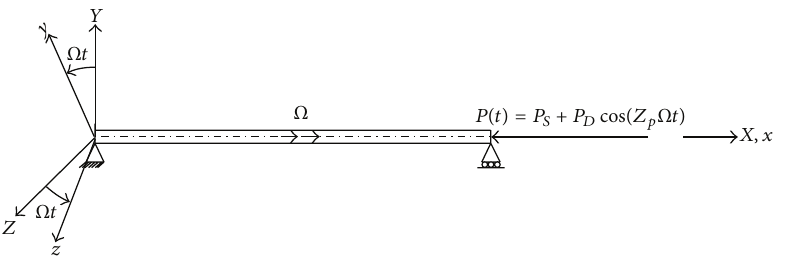
Figure 1: The rotating ship shaft and coordinate